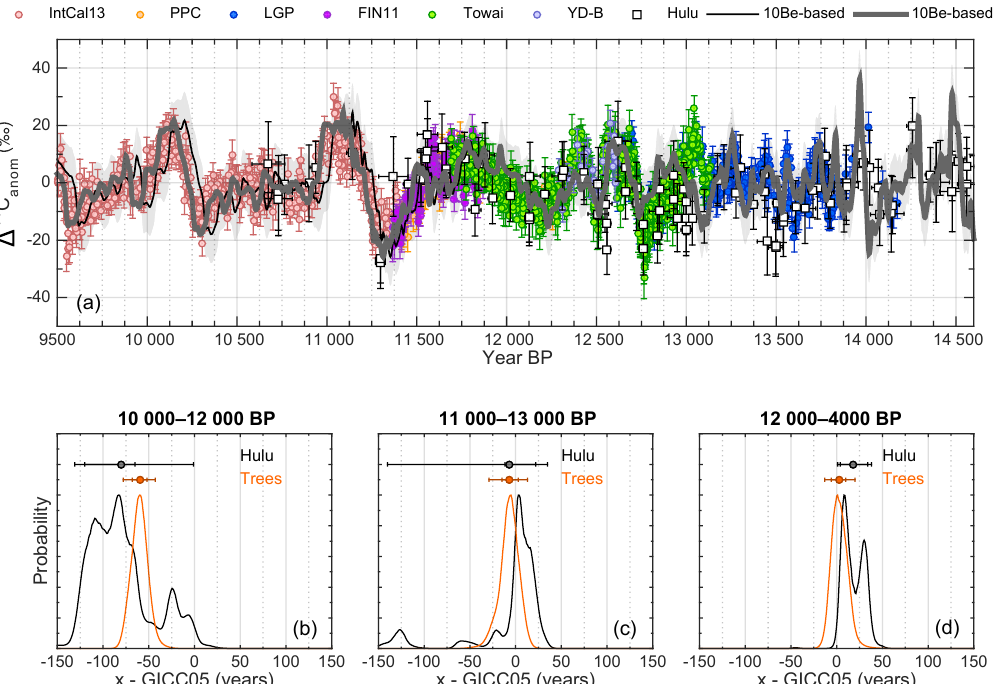
Figure 7. Synchronization of GICC05 to tree-ring and Hulu Cave records during the last deglaciation. (a) Ice-core-based modeled (cid:49) 14 C anomalies on the original GICC05 timescale (thin black line, light grey shading encompasses the ± 10‰ uncertainty ( ± 1 σ ) of the modeled (cid:49) 14 C based on the carbon cycle sensitivity experiments by Adolphi and Muscheler, 2016) and synchronized timescale (bold grey line). Tree- ring data underlying IntCal13 are shown in pink. Revised Northern Hemisphere tree-ring data according to Hogg et al. (2016) are shown in orange (preboreal pines), dark blue (late glacial pine), and light blue (Younger Dryas B chronology). New kauri (cid:49) 14 C data by Hogg et al. (2016) are shown in purple (FIN11) and green (Towai). Hulu Cave H82 (cid:49) 14 C data are shown as white squares. All symbols are shown with ± 1 σ error bars. All data are FFT filtered to isolate (cid:49) 14 C variations on timescales <1000 years. (b–d) Inferred probability distributions of timescale differences between GICC05 and tree rings (orange) and Hulu Cave (black). The symbols and error bars denote means and 68.2% and 95.4% confidence intervals of the inferred timescale difference. Each of the lower panels refers to a 2000-year subsection of the data indicated at the top of each